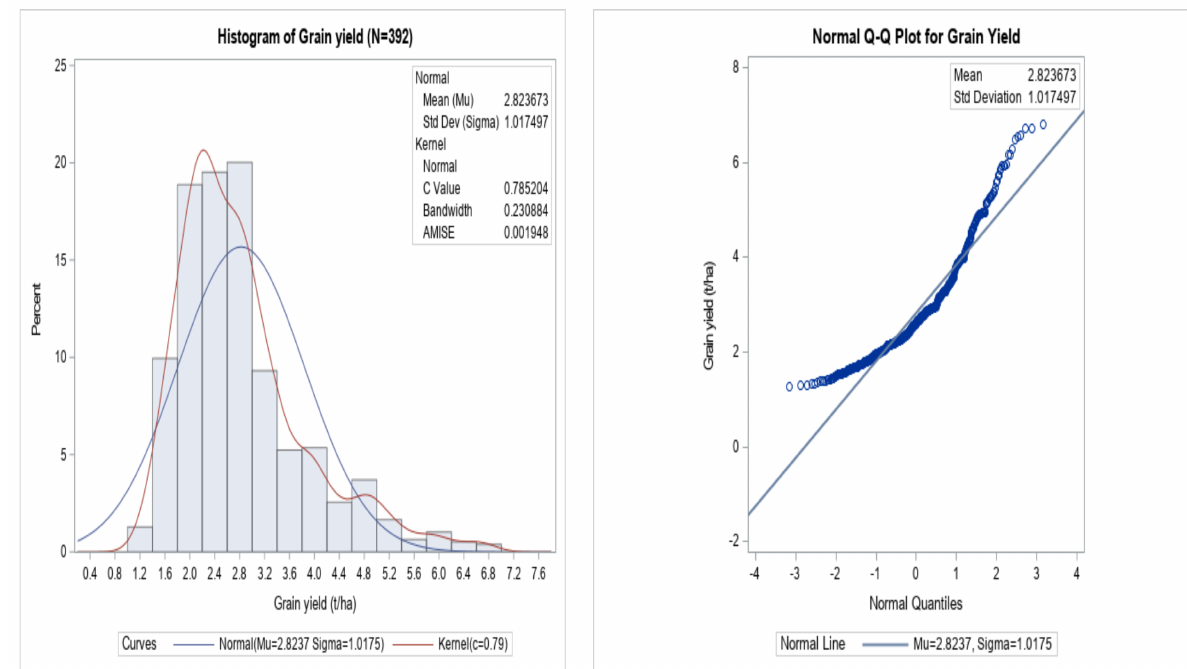
Figure 1. Histogram and Q—Q plot of grain